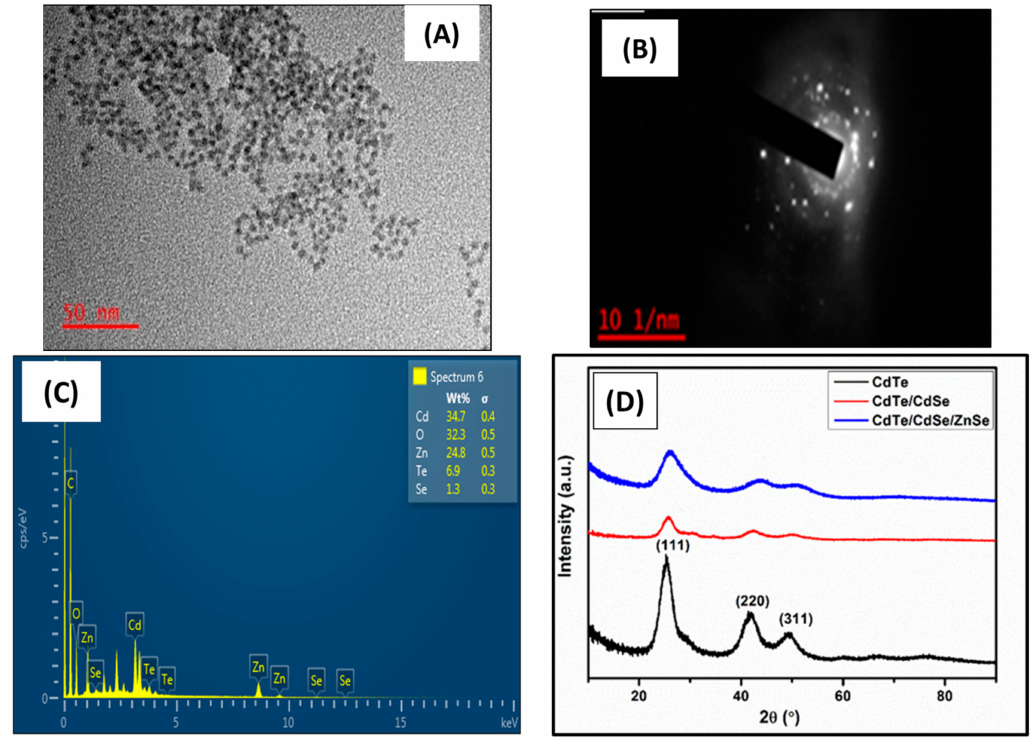
Figure 2. TEM image ( A ). SAED ( B ), EDX spectrum ( C ) and XRD spectra ( D ) of the as-synthesized MPA-capped CdTe/CdSe/ZnSe quantum